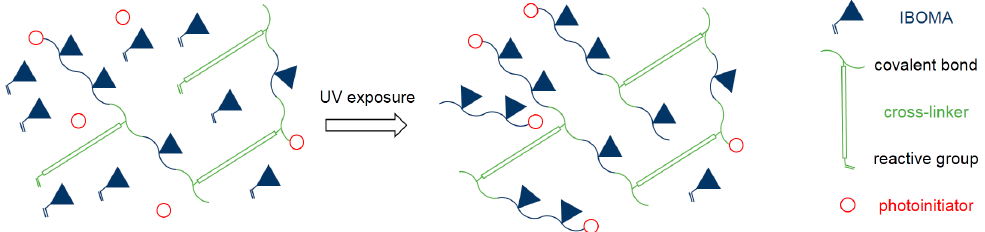
Figure 8. Uncured IBOMA possibly acting as plasticizer in the green part ( left ), and further curing leading to more covalent-bond IBOMA molecules ( right ).